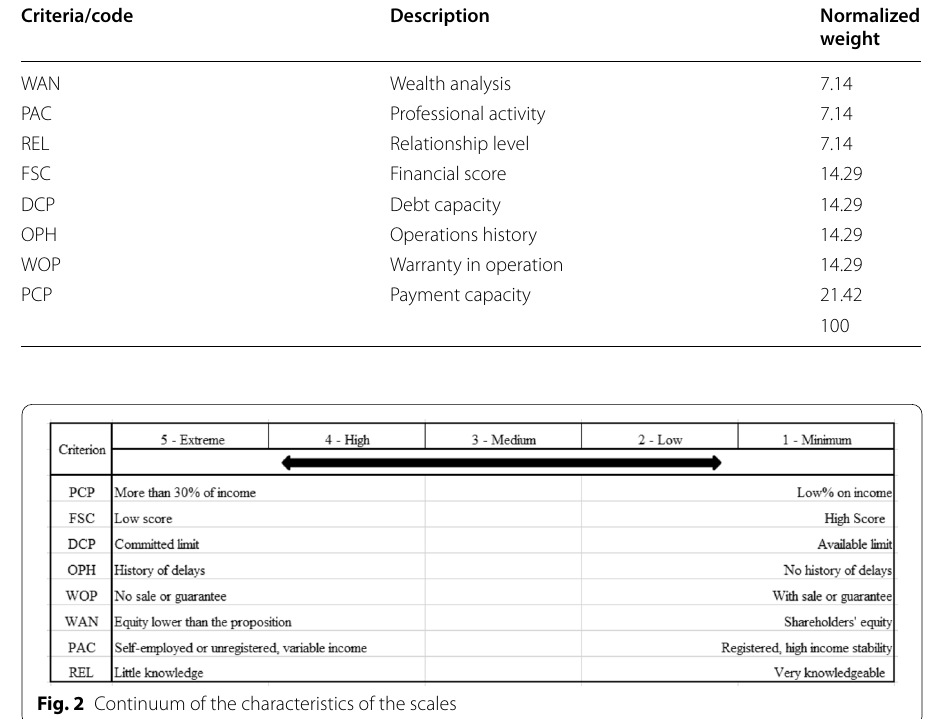
Table 5 Importance and weight of the criteria